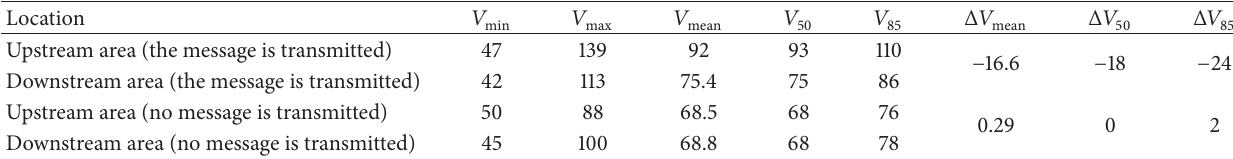
Table 2: The speed data summary in different scenarios.